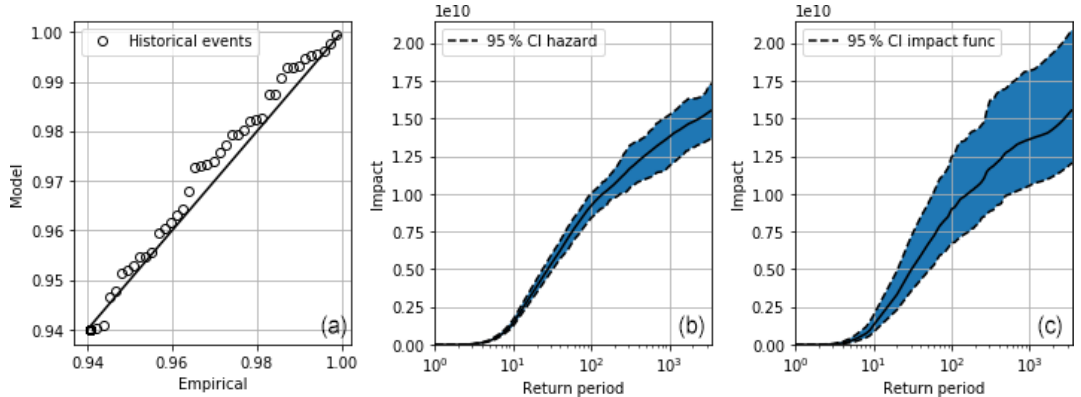
Figure 7. Quality metrics of the impact distribution. (a) shows the probability-probability plot. (b) shows the mean value and the 95% confidence interval (CI) when sampling on the hurricane tracks and (c) represents the 95% CI when sampling on impact functions with a maximal 10% shape modification, allowing to assess the uncertainty introduced by the models. Table 3. Average annual impact and exceedance impact level for several yearly return periods in millions of USD. Island